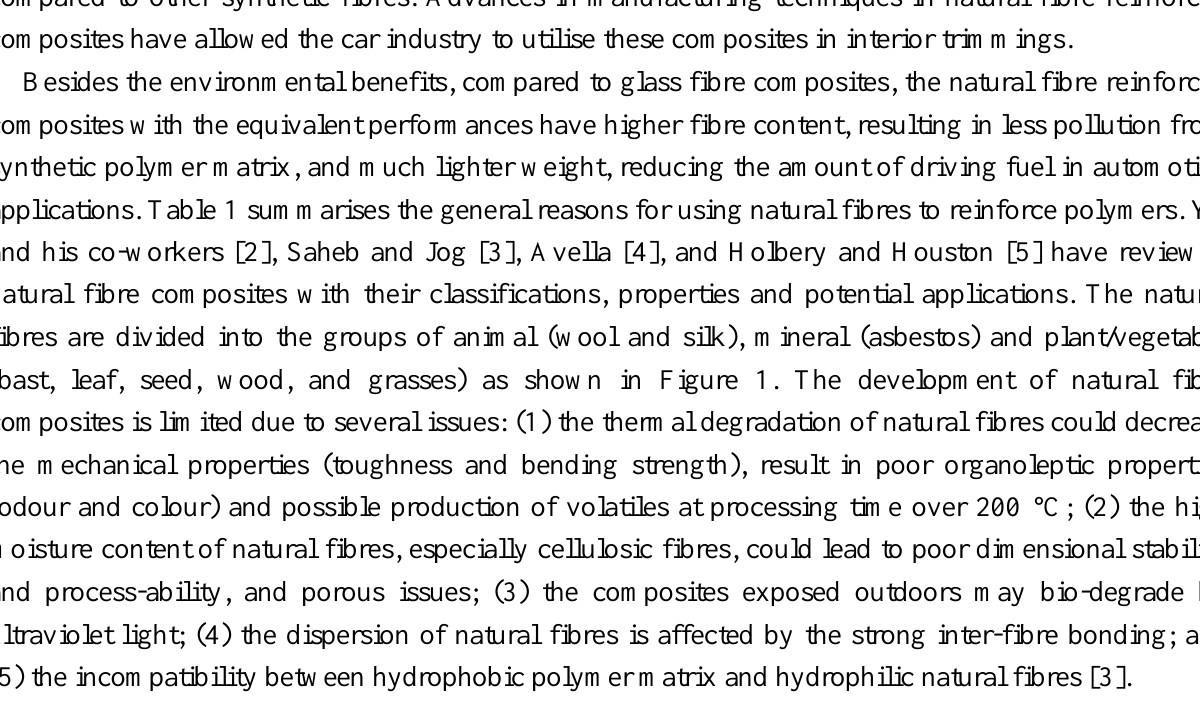
Table 1. Comparison between natural fibres and synthetic fibre